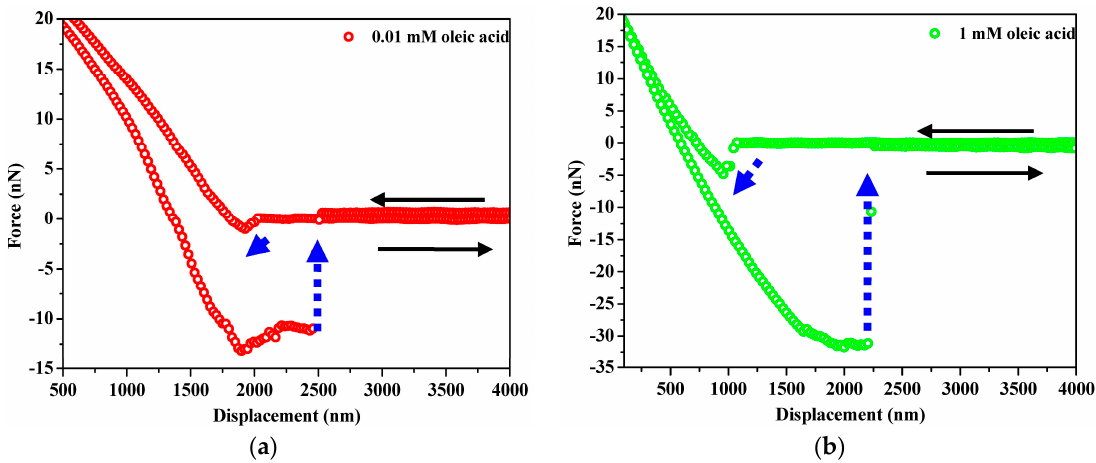
Figure 9. Force between PMMA colloid probe and oxidized PG in presence of oleic acid: ( a ) 0.01 mM oleic acid; ( b ) 1 mM oleic acid.